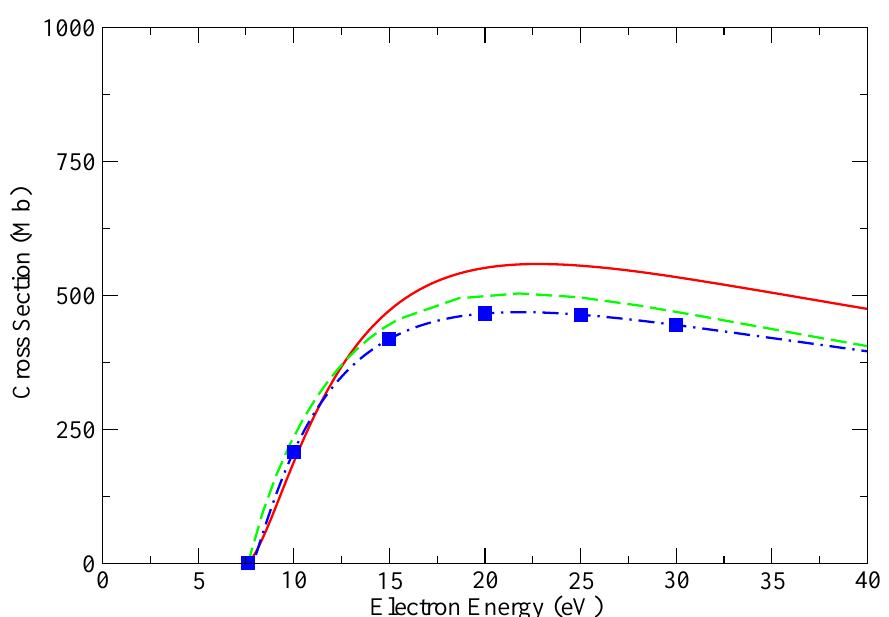
Figure 4. Electron-impact direct ionization of W from the 6 s subshell. Solid line (red): semi-relativistic distorted-wave cross section, dashed line (green): fully-relativistic distorted-wave cross section, dot- dashed line with solid squares (blue): TDCC cross section (1.0 Mb = 1.0 × 10 − 18 cm 2 ).